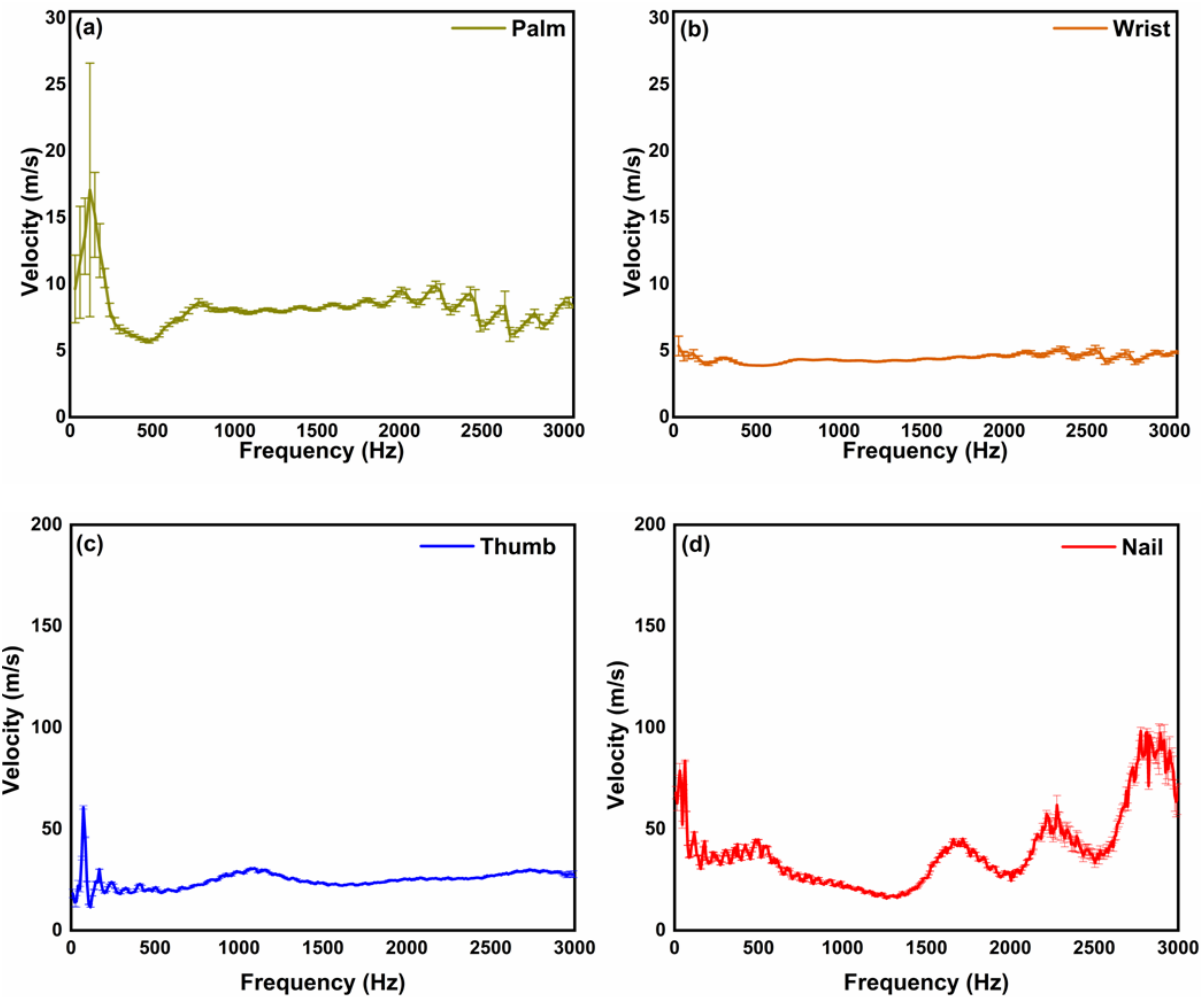
Figure 3. Surface acoustic wave velocity measured on ( a ) palm, ( b ) wrist, ( c ) thumb, and ( d ) nail of a healthy volunteer.